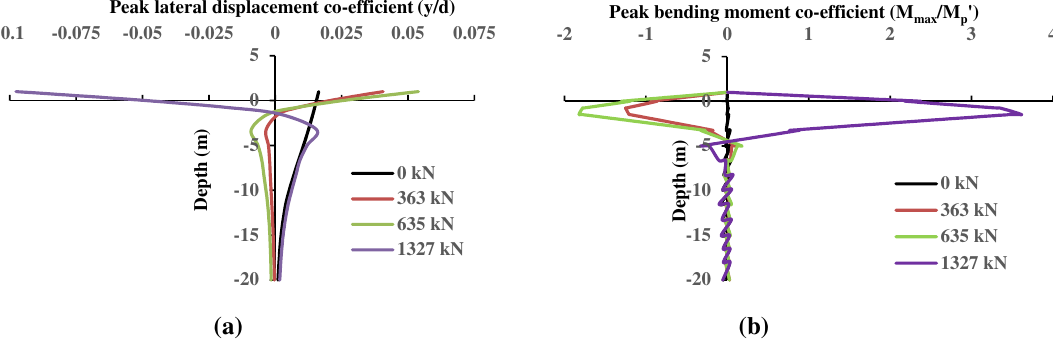
Fig. 17 Variation of a peak lateral displacement and b peak bending moment co-efficient of pile for different combinations of vertical load- ing in non-liquefiable condition of RCD soil when subjected to scaled IMV motion